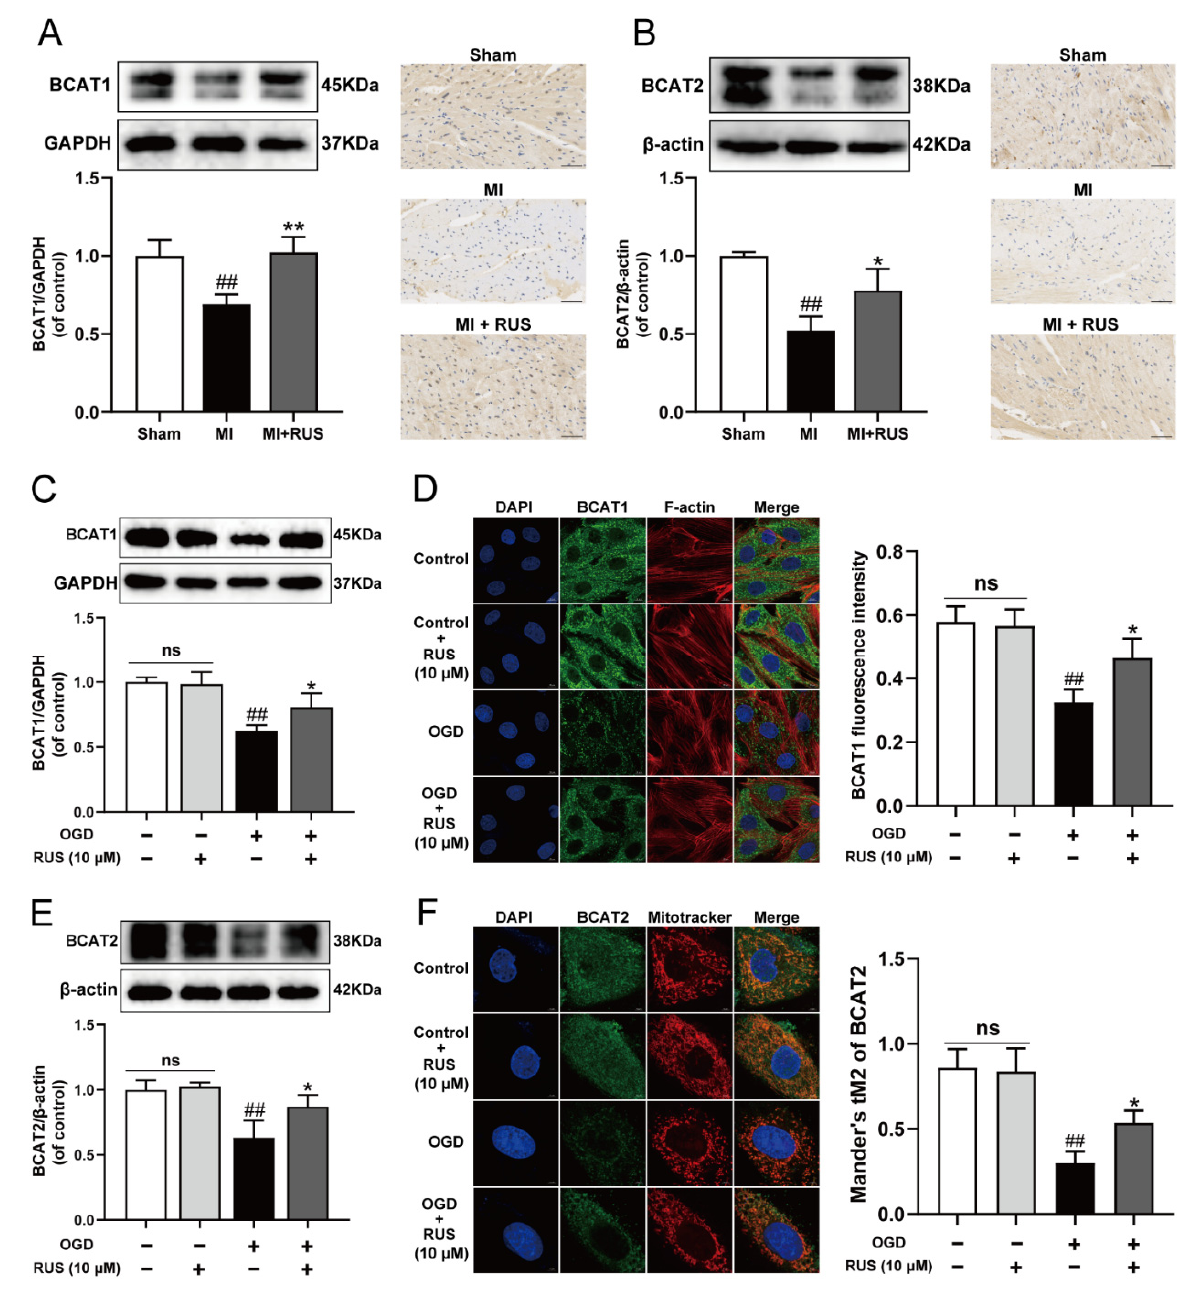
Figure 4. RUS significantly promoted the expression of BCAT1/BCAT2 in MI. Western blotting and immunohistochemistry analysis of ( A ) BCAT1 and ( B ) BCAT2 in the heart tissues of the sham, MI and MI treated with 0.75 mg/kg RUS groups (scale bar, 50 µm, n = 3). ( C ) Western blotting analysis of BCAT1 in H9c2 cardiomyocytes ( n = 3). ( D ) Immunofluorescence images of BCAT1 in H9c2 cardiomyocytes (scale bar, 10 µ m, n = 3). ( E ) Western blotting analysis of BCAT2 in H9c2 cardiomyocytes ( n = 3). ( F ) Immunofluorescence images of BCAT2 in H9c2 cardiomyocytes (scale bar, 5 µ m, n = 3). Results were expressed as mean ± SD. ## p < 0.01 vs. the sham or control group, * p < 0.05, ** p < 0.01 vs. the MI or OGD